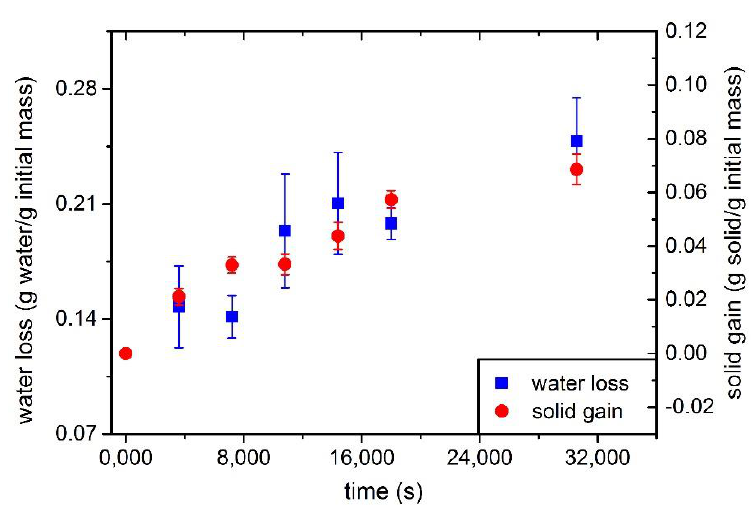
Figure 2. Water loss (blue squares) and solid gain (red circles) versus time during the osmotic dehydration of courgette in the CuSO 4 solution. Error bars represent standard uncertainty.